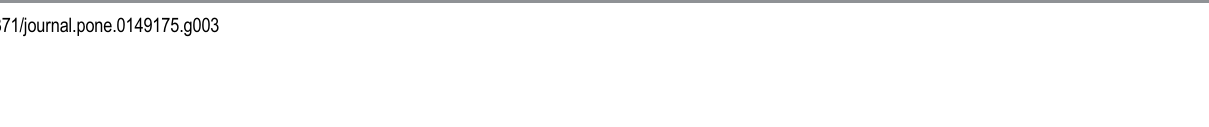
PLOS ONE | DOI:10.1371/journal.pone.0149175 March 11,